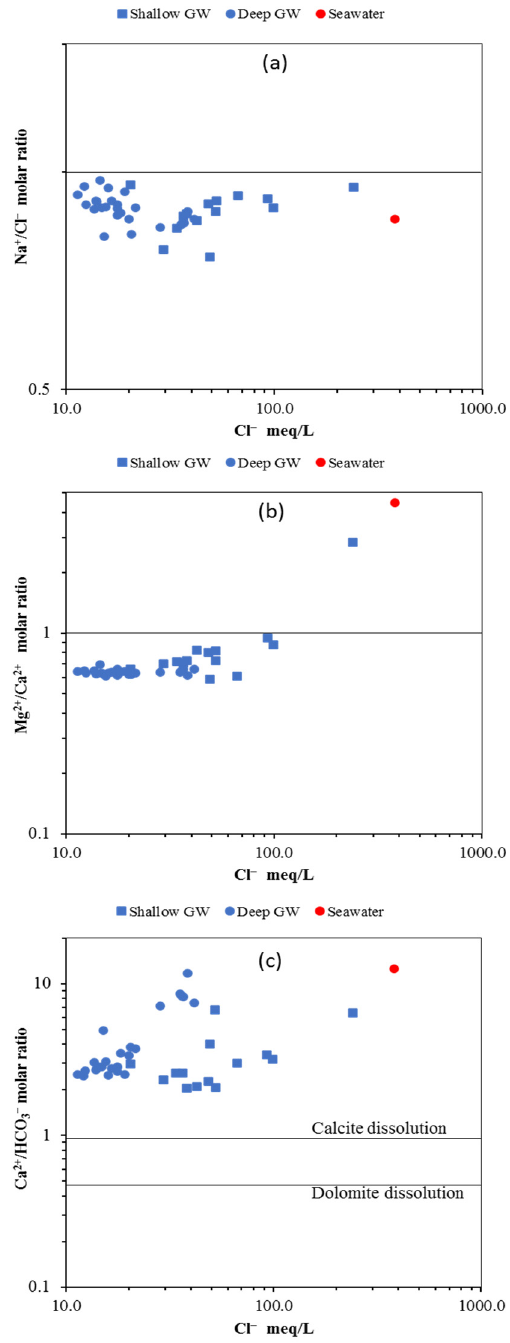
Figure 13. Ion ratio diagram ( a ) Na + /Cl − ratio versus Cl − , ( b ) Mg 2+ /Ca 2+ ratio versus Cl − , and ( c ) Ca 2+ /HCO 3 − ratio versus Cl − .